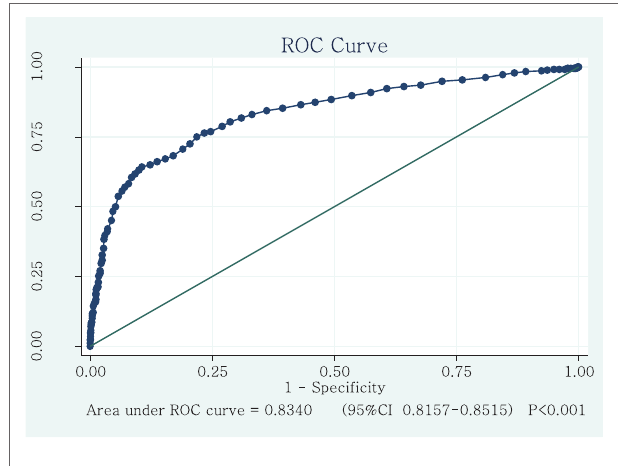
FIGURe 1 | ROC curve with which to determine the predictive value of the assessment of sensory processing and executive functions in childhood scale in the diagnosis of children with a disorder.